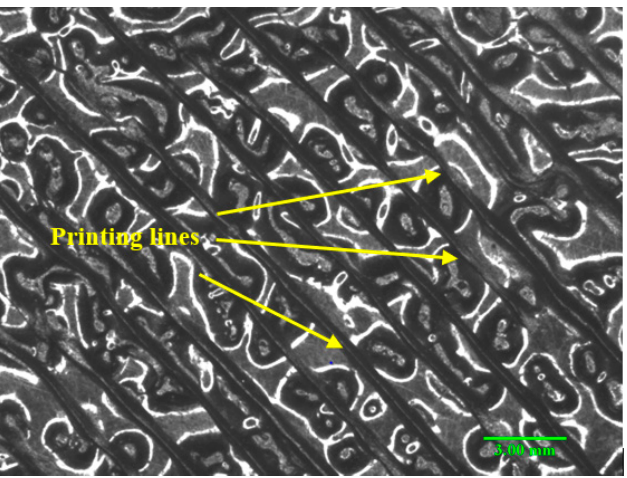
Figure 11. Microscopic image for the surface of pure PLA sample.